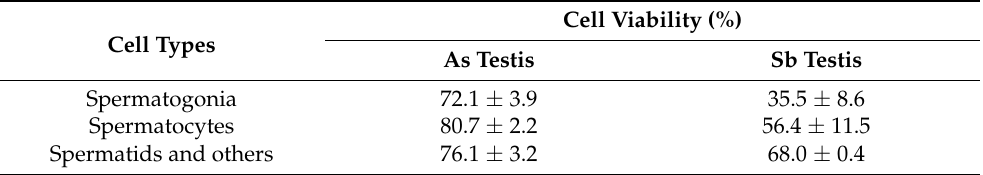
Table 3. The method of cryopreservation validated in new batch of American shad and Asian